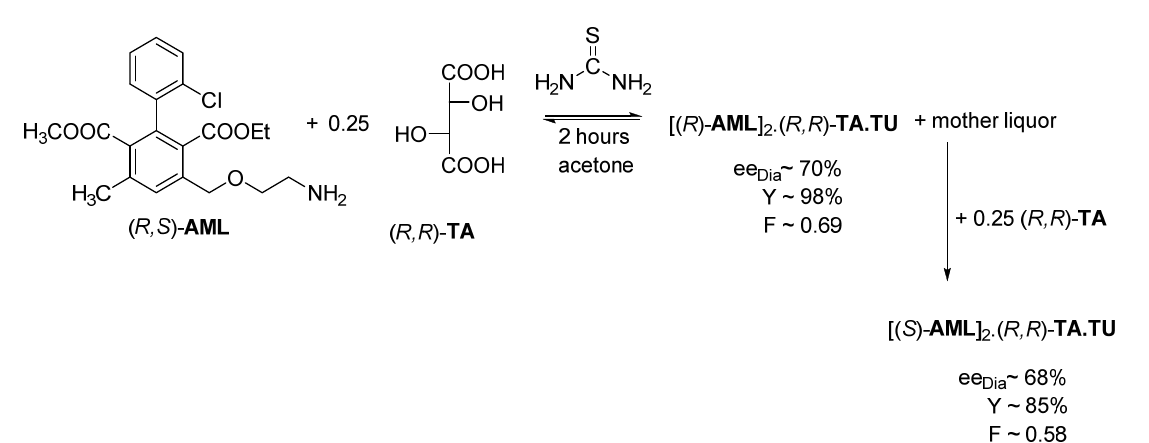
Figure 15. During the tandem resolution, the other Amlodipine enantiomer crystallizes out from the mother liquor with the originally used resolving agent.